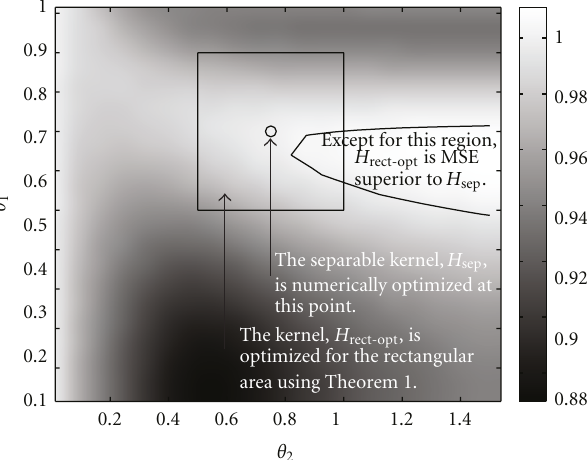
Figure 4: The ratio between the MSE of the optimal kernel function for the family of nonstationary AR(1)-processes and the MSE of a separable kernel function. The first kernel has been optimized, as given by Theorem 1, for the processes with parameters inside the rectangle. The lengths and the amplitudes of the two Hanning windows of the separable kernel have been optimized for the parameter values at the circle. The black contour shows the border where the two kernels give equally MSE. Outside this region the kernel optimized as described in this paper is MSE superior to the separable